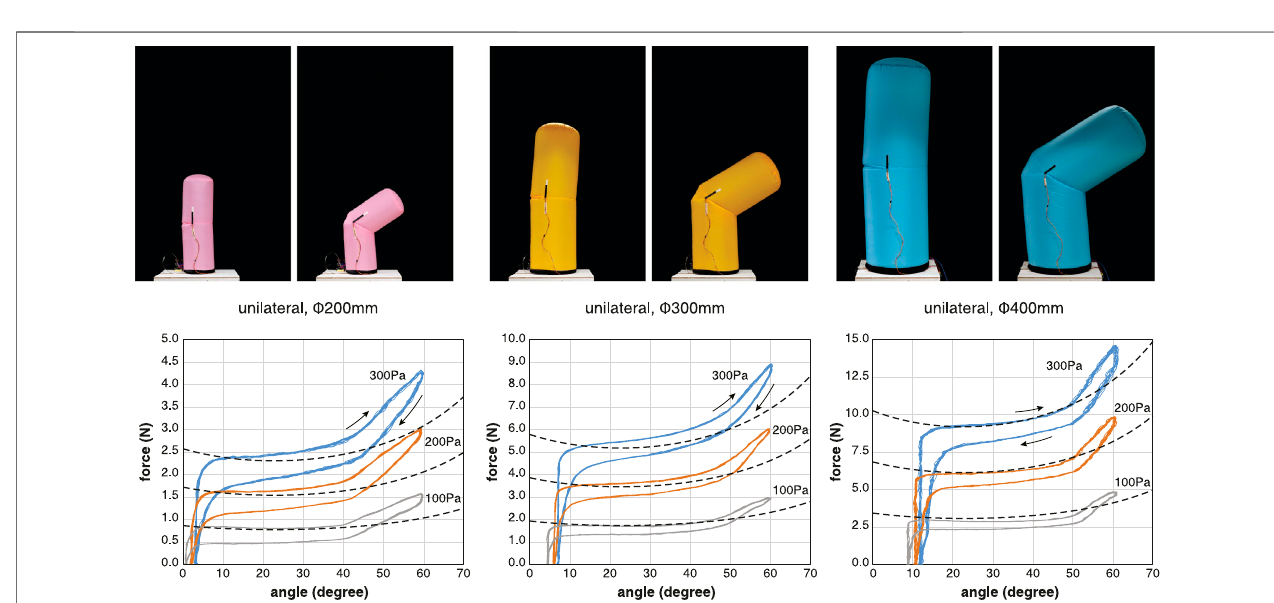
FIGURE 5 | Relationships between the tensile force and angle of unilateral joints under constant pressure conditions. The dotted line represents the theoretical model. The in fl atables used for the measurement were U200, U300, and U400. Plots of 10 cycles at the pressure conditions of 100Pa, 200Pa, and 300Pa. The pulling angle of the tendon is 30 ° . Note that the scale of the vertical axis is